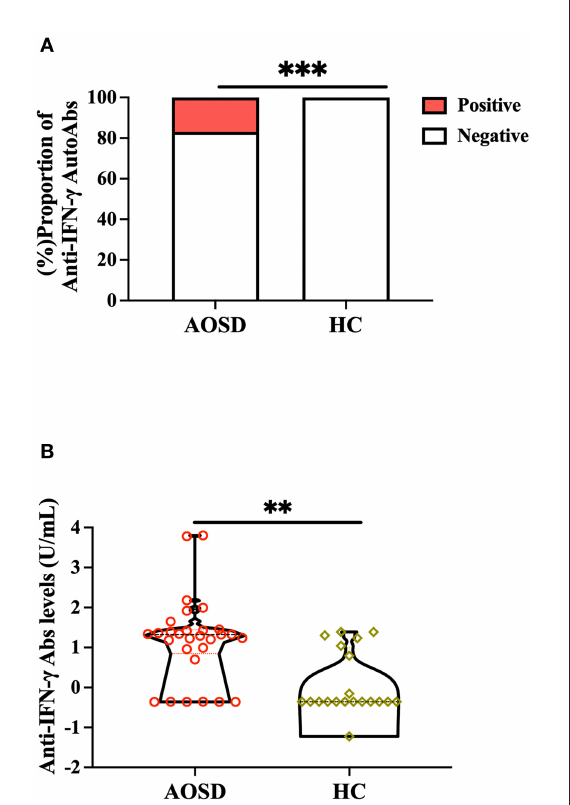
FIGURE1 Comparison of (A) positive rates and (B) titers of anti-IFN- γ autoAbs between AOSD patients and HC participants. Anti-IFN- γ autoAbs was then determined by enzyme-linked immunosorbent assay (ELISA). *** p < 0.001, determined by the Chi-squared test (A) , or ** p < 0.01, determined by the Mann-Whitney U test (B) . AOSD, adult-onset Still’s disease; HC, healthy control; IFN- γ , interferon- γ